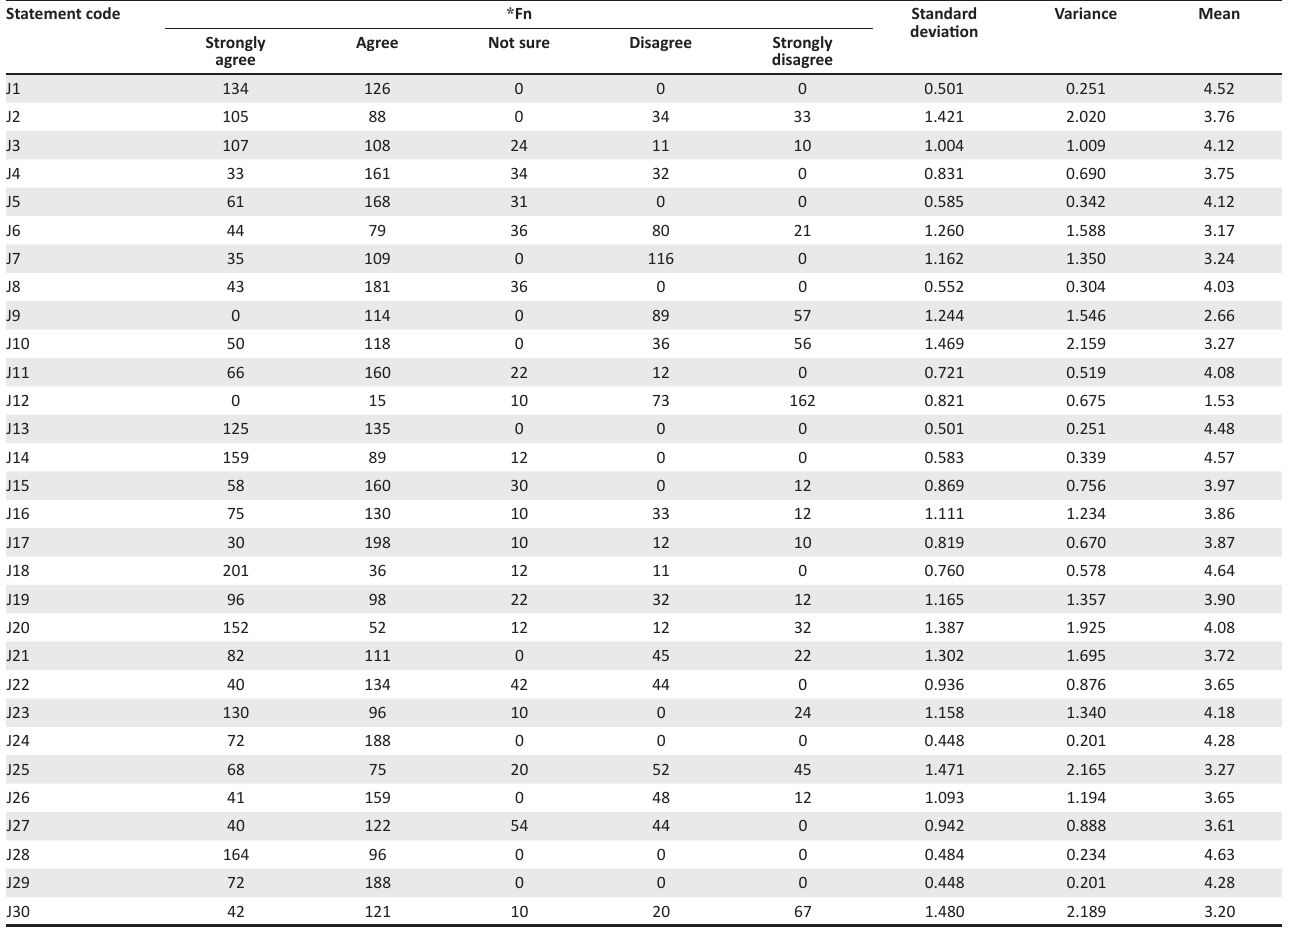
TABLE 2: Distribution of responses to service quality variables of bus rapid transit in the City of Cape Town. Statement